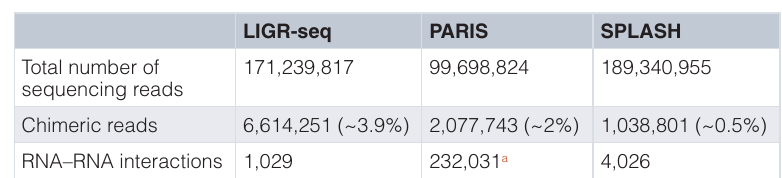
Table 1. Comparison of read statistics.